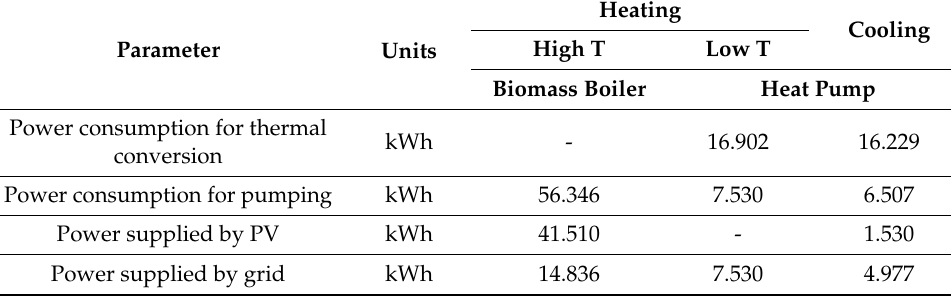
Table A2. Electricity energy consumption.